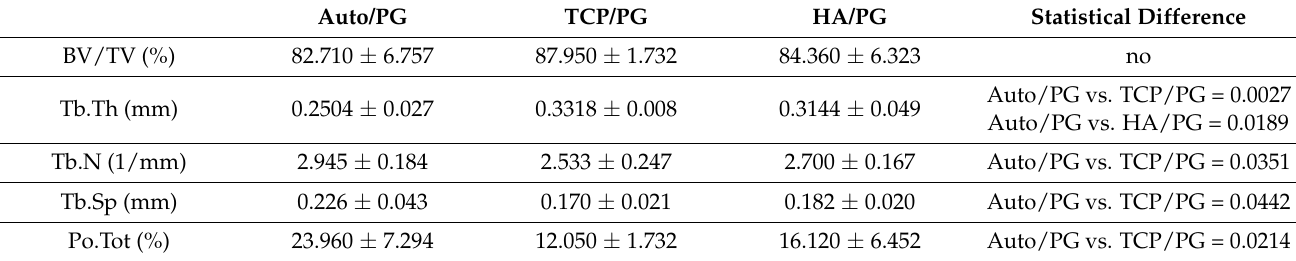
Table 2. Micro-CT results: Auto/PG, TCP/PG and HA/PG ± standard deviation (SD). Auto/PG TCP/PG HA/PG Statistical Difference BV/TV (%) 82.710 ±